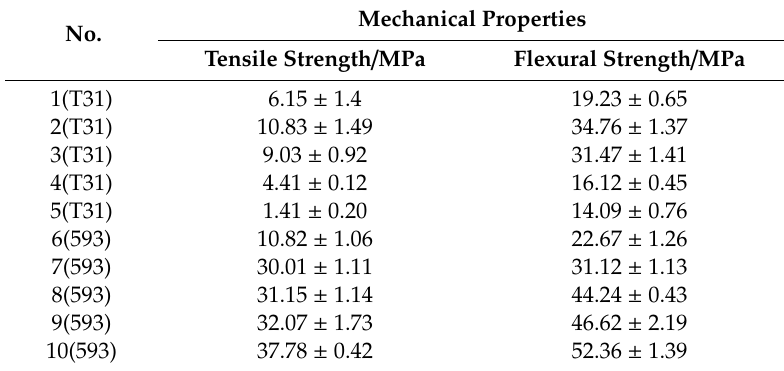
Table 8. E ff ect of curing agent on mechanical